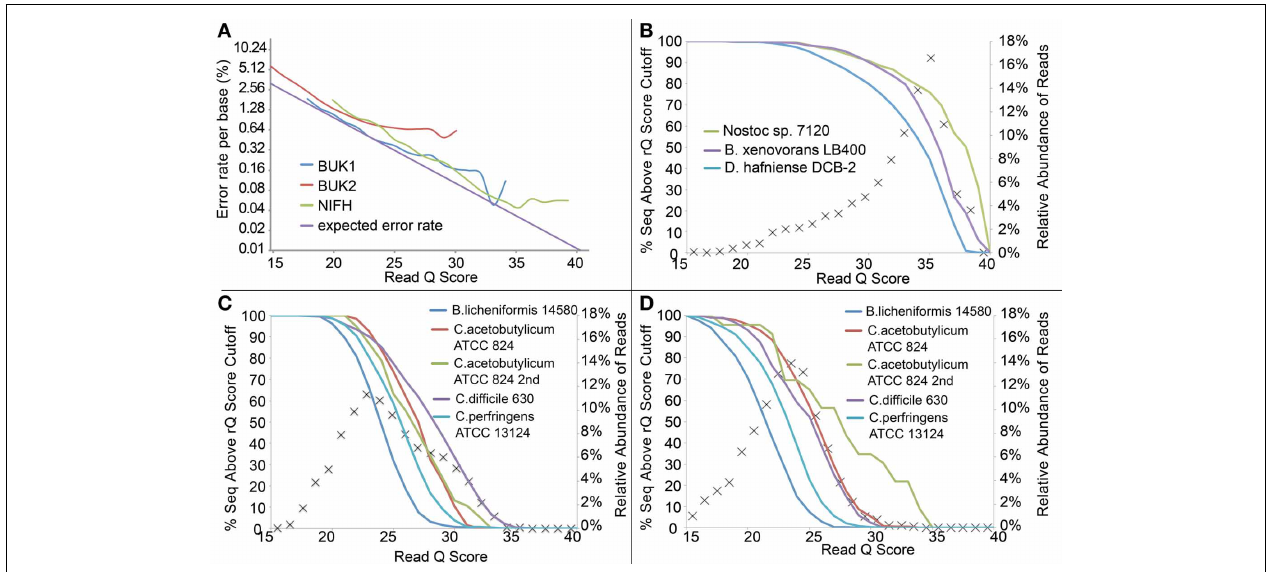
FIGURE 4 | (A) Expected error rate and observed error rate per base (nucleotide insertions, deletions, and substitutions) from the three defined community data sets. Only data points with more than 5 reads are shown. The expected error rate was calculated based on the formula in the Materials and Methods. (B–D)